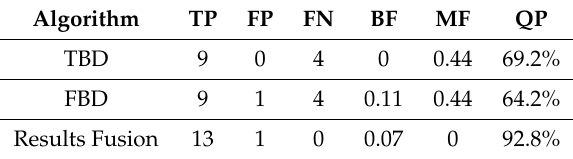
Table 7. Accuracy assessment of applying BDSV on Ist7 that includes 13 building objects.